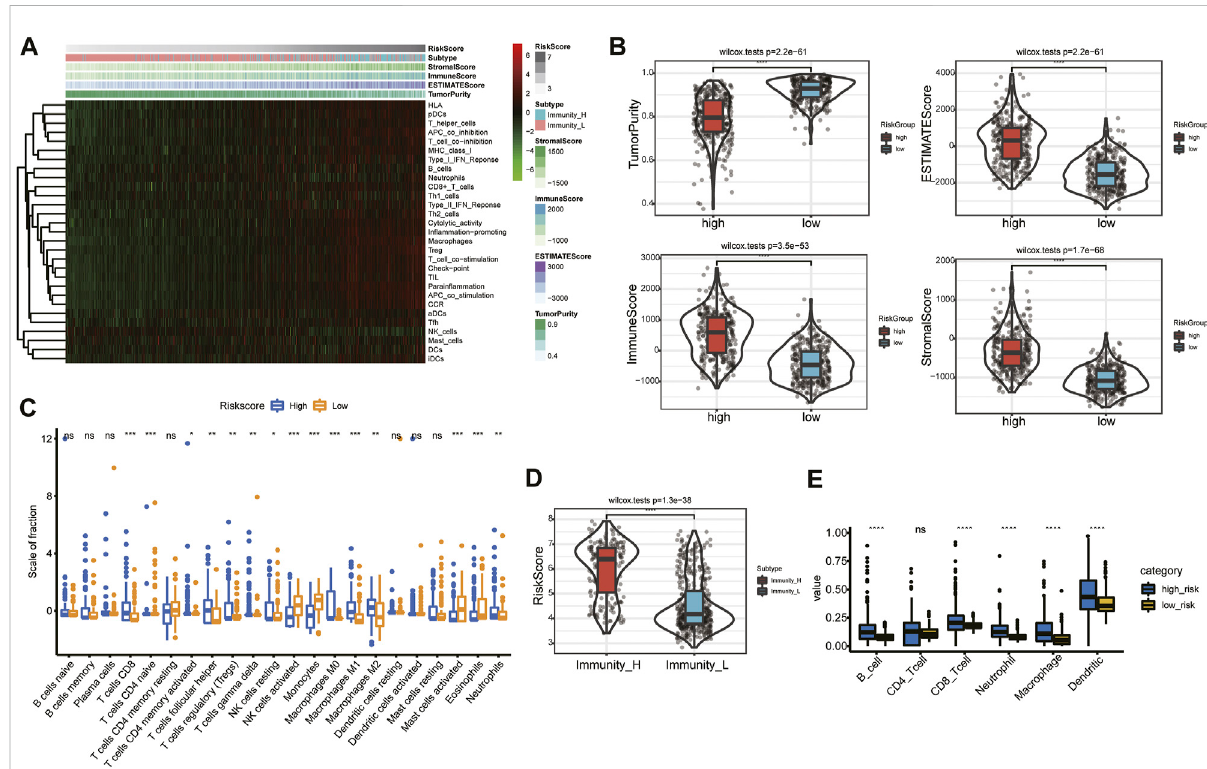
FIGURE 8 RelationshipbetweenrisksignatureandTIMEintheTCGAdatabase. (A) HeatmapofriskscoreandthetwoimmunitysubtypesbasedonssGSEA. (B) Comparison of tumor purity and of ESTIMATE, immune, and stromal scores in the high- and low-risk groups. (C) Association between immune cells and the risk signature. (D) Comparison of risk score between the immunity-high and immunity-low subtypes. (E) Abundances of six immune cells in the high- and low-risk